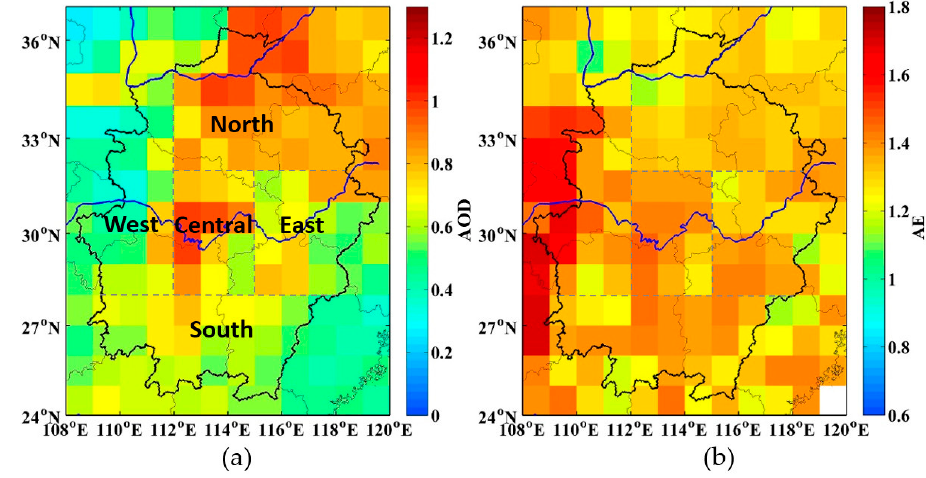
Figure 2. Annual average ( a ) AOD and ( b ) AE over the central China from 2001 to 2015.